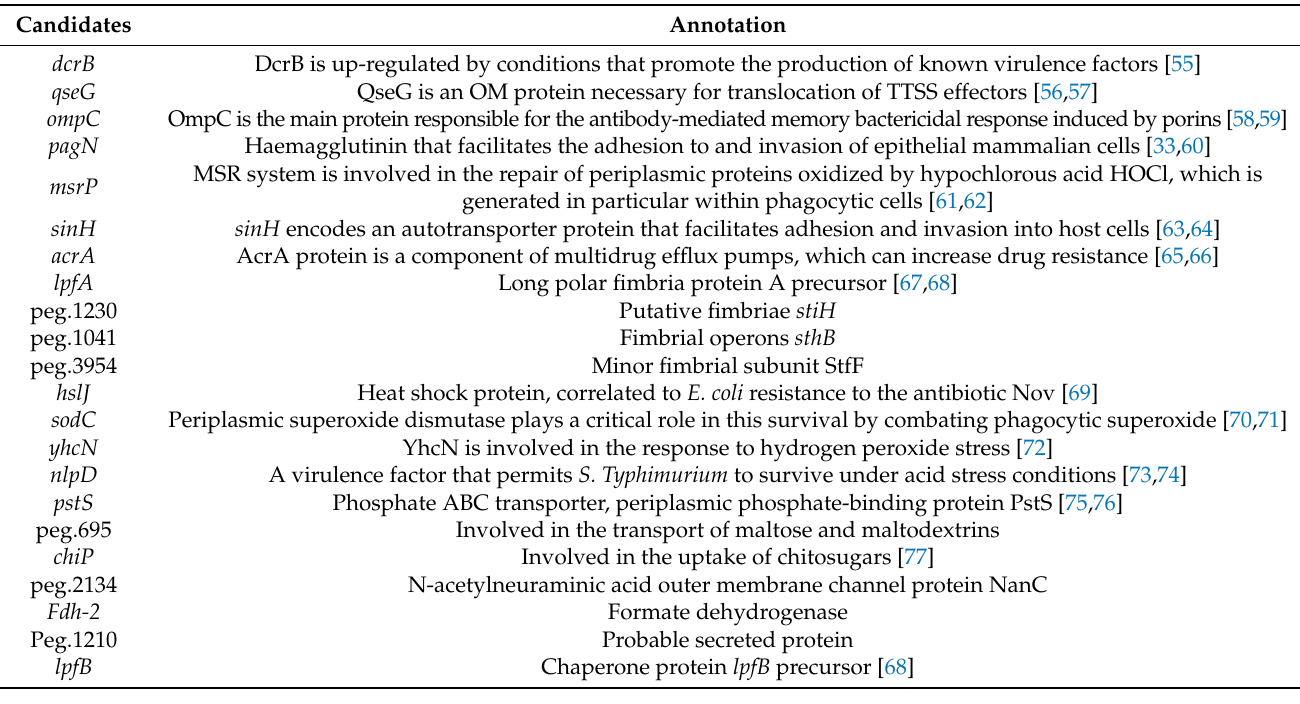
Table 3. Functional annotation of the potential vaccine candidates identified in S. Pullorum R51.